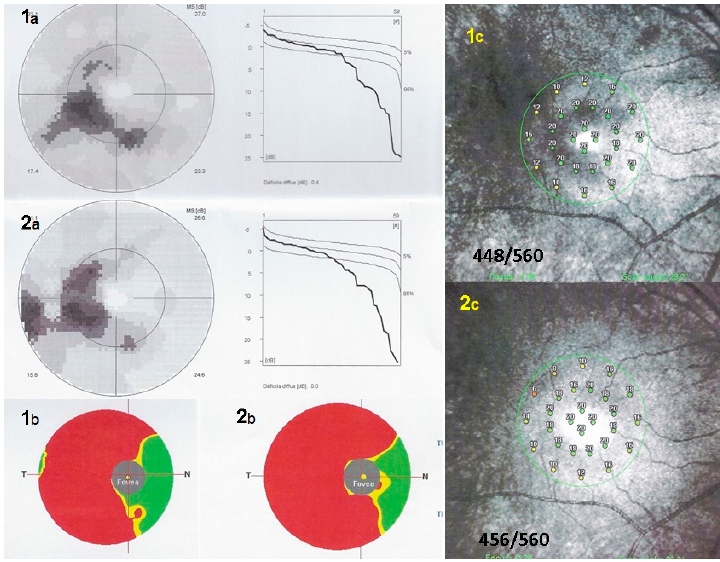
Figure 9. Visual field findings, ganglion cell layer and microperimetry in case of AZOOR at presentation and after 18 months of follow-up in patient 2. Visual field ( 1a ) showed a limited scotoma also seen after 18 months ( 2a ). Ganglion cell layer ( 1b , 2b ) shows a substantial loss outside the fovea (corresponding to scotoma in 1a ) which increased slightly after 18 months ( 2b ). Microperimetry shows a score of 448 OD at presentation ( 1c ) which did not decrease after 18 months of follow-up ( 2c ).